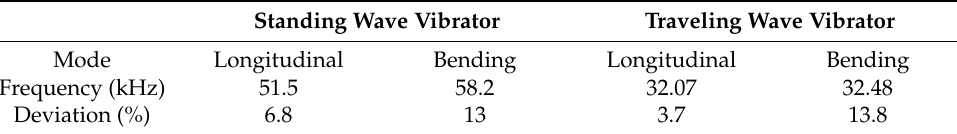
Figure 9. Frequency response characteristics of impedance and phase for the traveling wave vibrator measured using an impedance analyzer. Table 4. Comparison of the resonant frequencies of the two modes obtained by simulation and experiment.